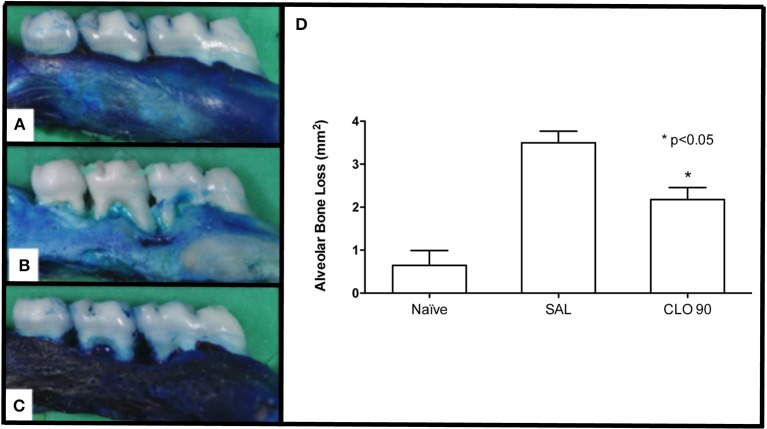
Effect of CLO on ABL in rats with EP. Naoïve hemimaxilla (A), Hemimaxilla from SAL group (B), Hemimaxilla tretated with CLO 90 mg/kg (C), Macroscopic Analysis (D). Bars represent the mean ± SEM of 6 animals per group. *P < 0.05 was considered to be significantly different compared with SAL (ANOVA followed by the Bonferroni test). (A–C, 4x magnification).